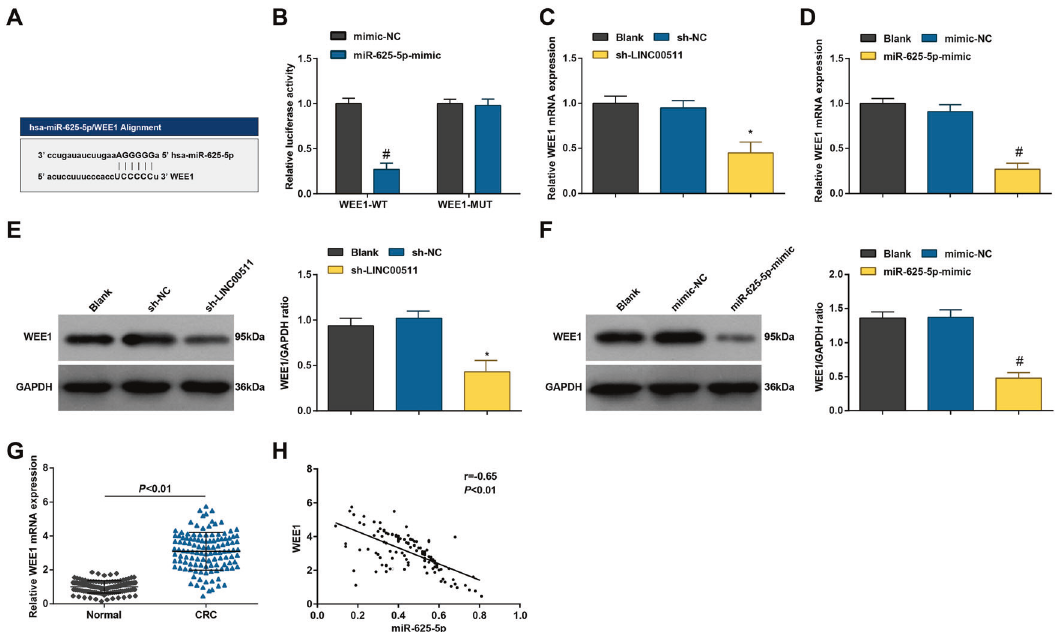
Fig. 6 LINC00511 positively while miR-625-5p negatively connects with WEE1. A StarBase website predicted the binding site of miR-625-5p and WEE1; B dual-luciferase reporter gene assay analyzed the binding site of miR-625-5p and WEE1; C RT-qPCR detected WEE1 mRNA expression in CC cells after regulation of LINC00511 and miR-625-5p; D western blot assay detected the WEE1 protein expression in CC cells after regulation of miR-625-5p; E , F western blot assay detected WEE1 protein expression in CC cells after regulation of LINC00511 or